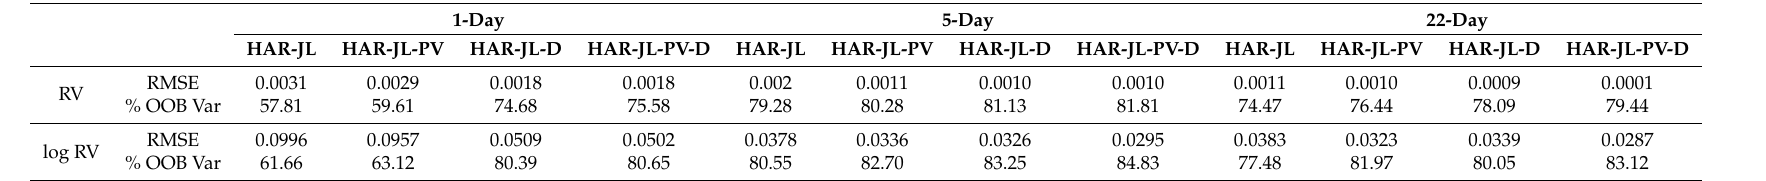
Table 2. Forecasting error of the realised volatility for the in-sample data from 1 January 2008 to 31 December 2013.